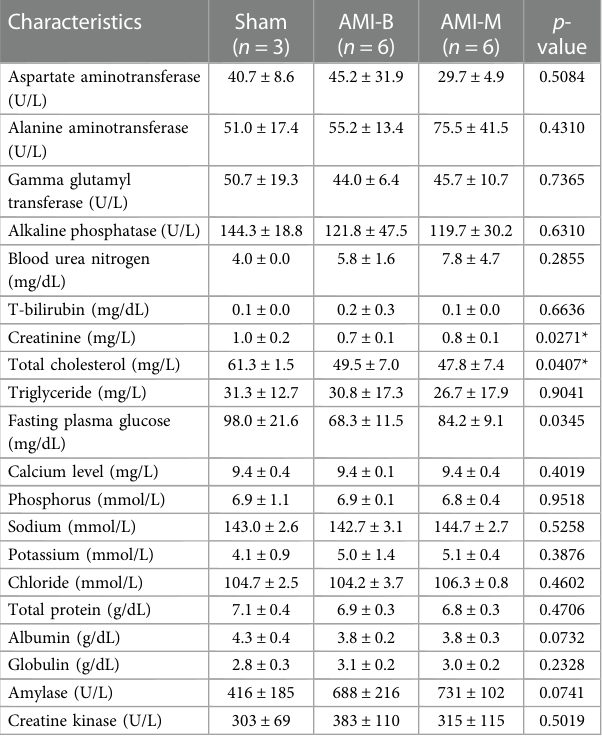
TABLE 4 Biochemistry characteristics of three groups at 5 months after AMI induction.